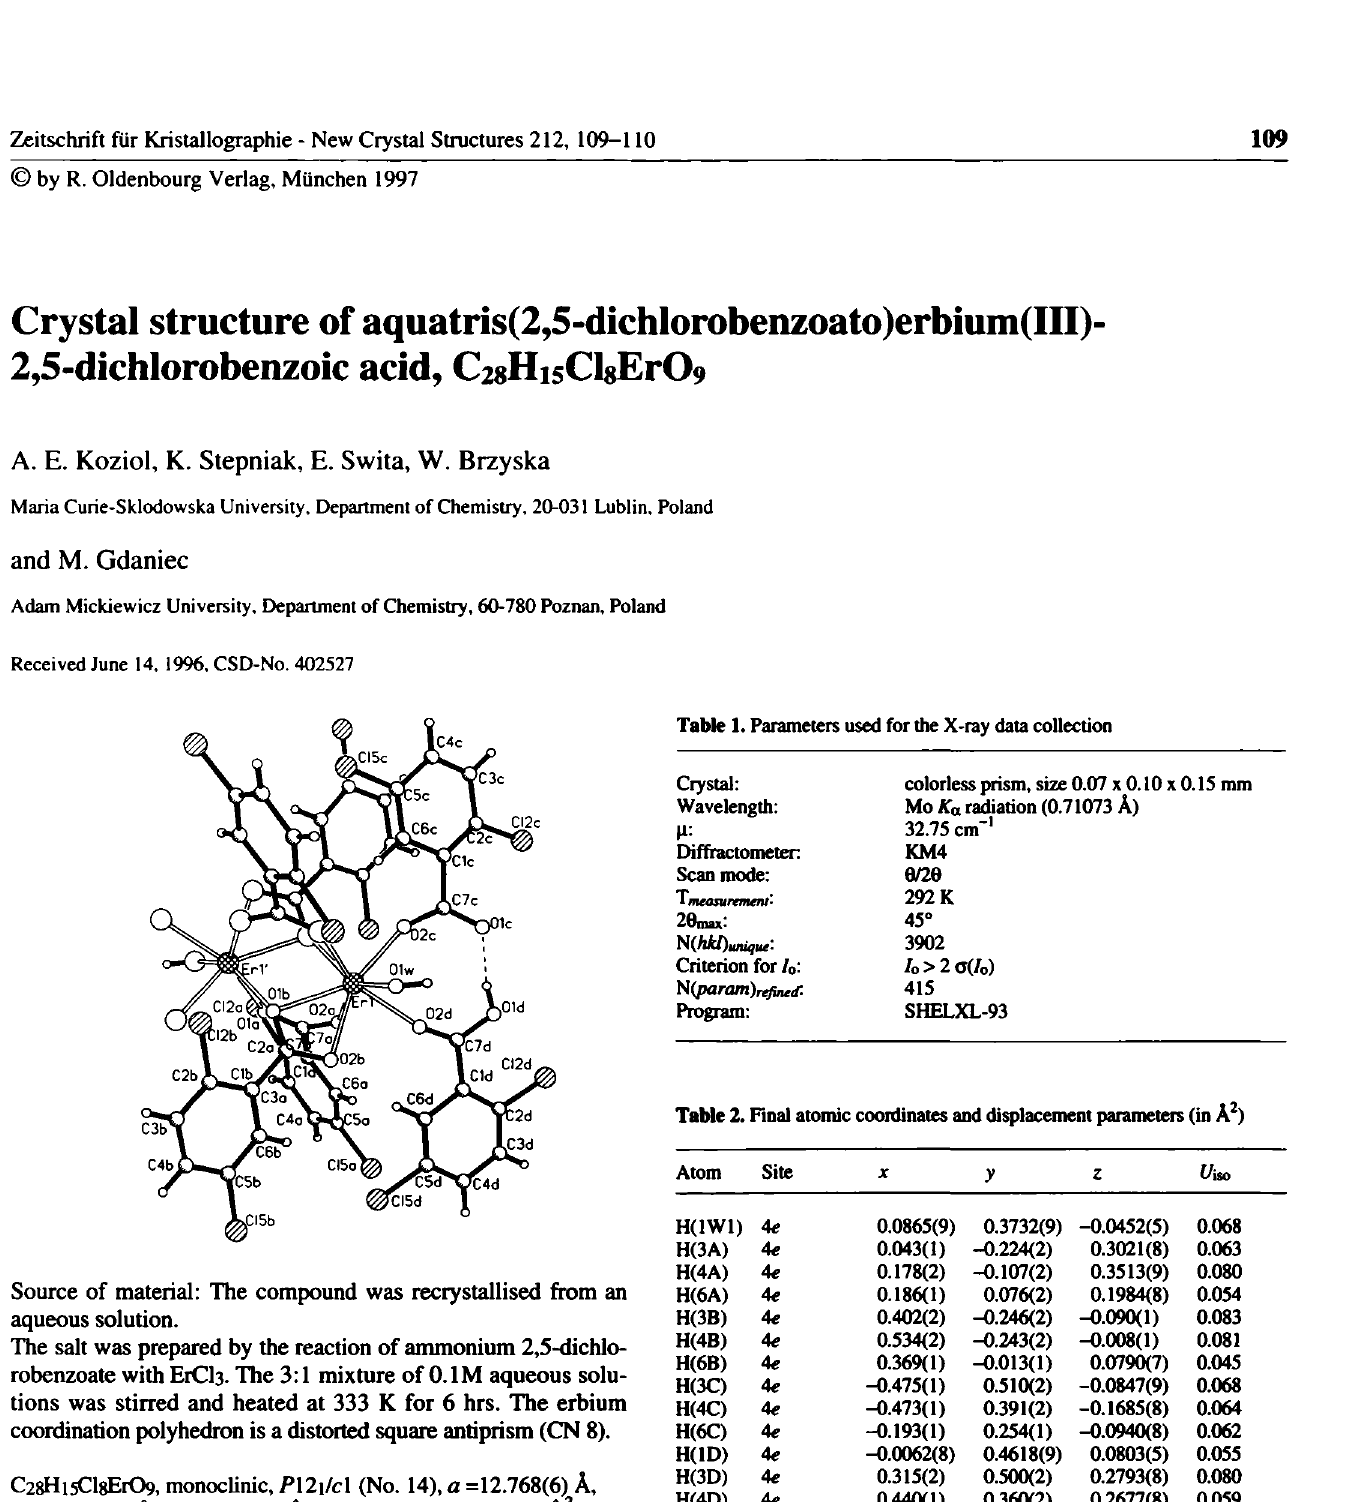
Table 2. Final atomic coordinates and displacement parameters (in A 2 )